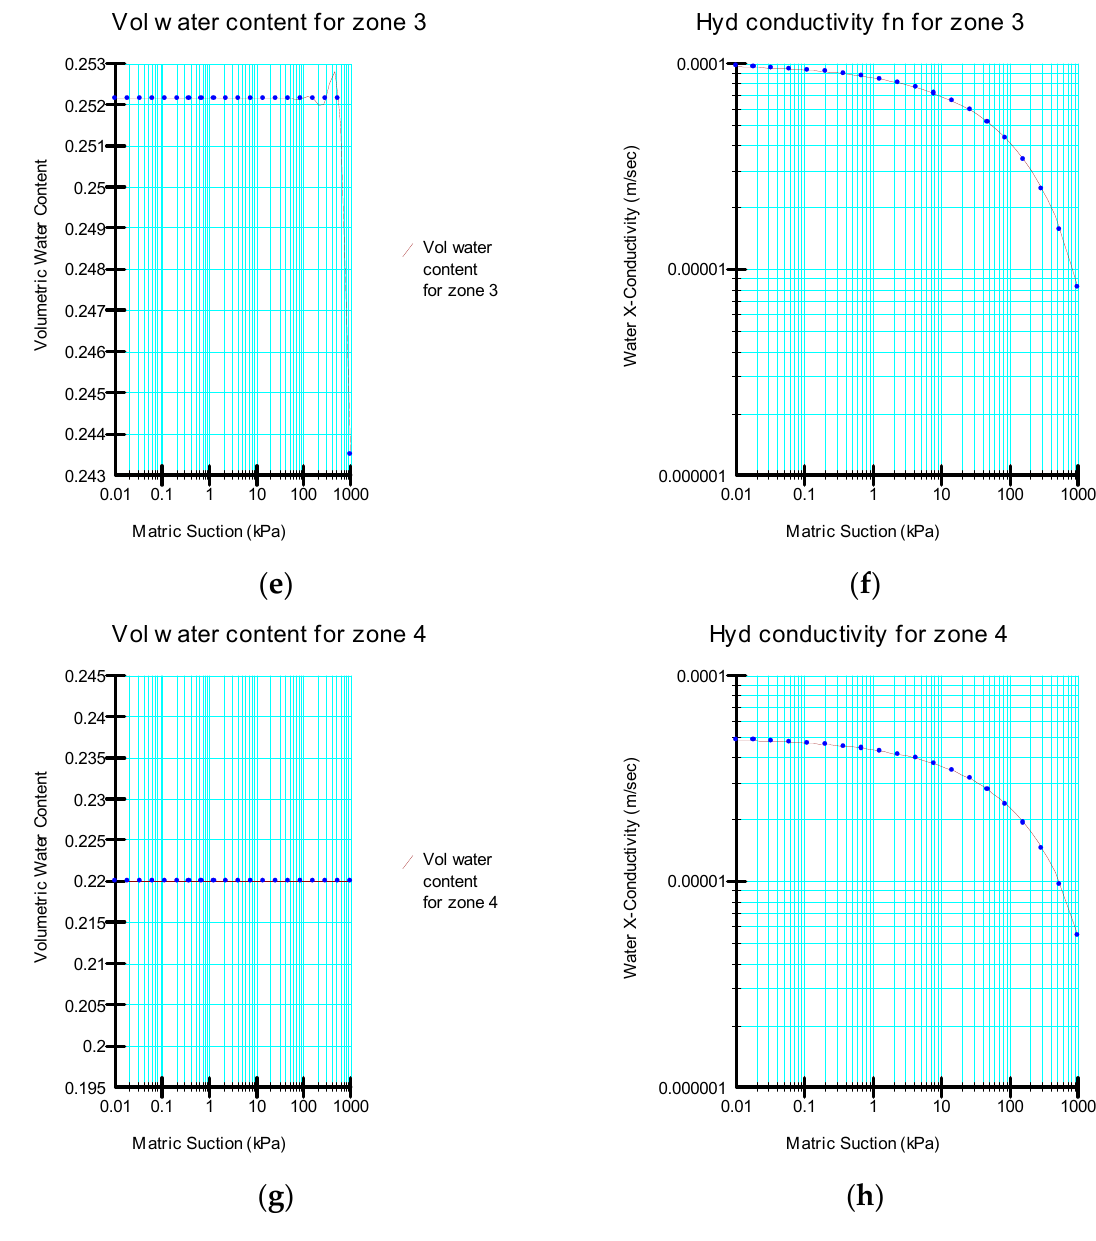
Figure 3. Volumetric water content and hydraulic conductivity functions: ( a ) volumetric water content from the first zone, ( b ) hydraulic conductivity function from the first zone, ( c ) volumetric water content from the second zone, ( d ) hydraulic conductivity function from the second zone, ( e ) volumetric water content for zone 3, ( f ) hydraulic conductivity function for zone 3, ( g ) volumetric water content for zone 4, ( h ) hydraulic conductivity function for zone 4.